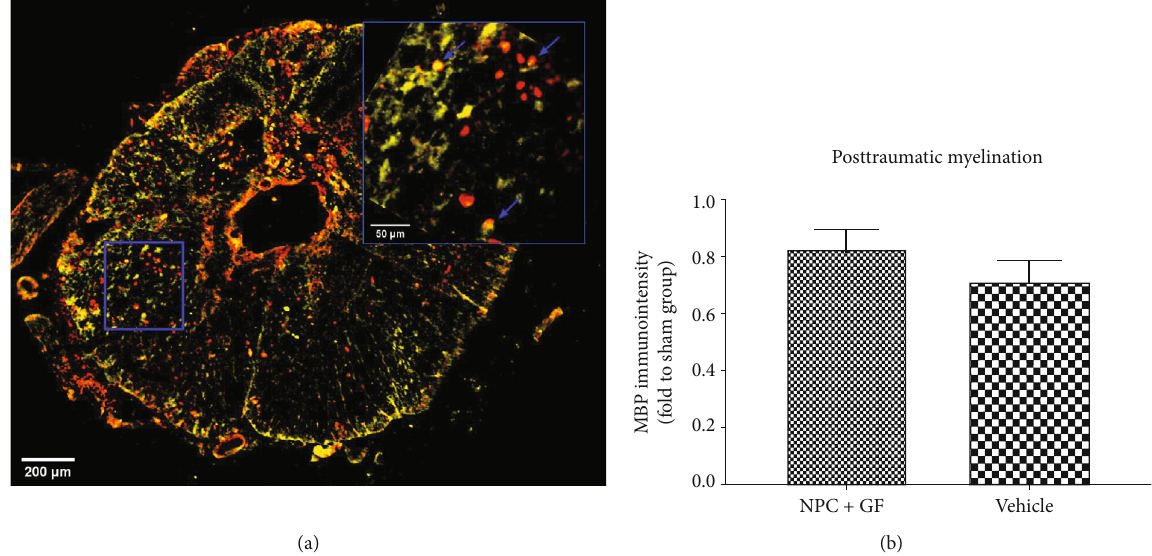
Figure 8: In vivo posttraumatic myelination 8 weeks after cervical SCI. (a) Spinal cord cross-section stained for APC (red), a marker for mature oligodendrocytes and MBP (yellow), depicting myelination (10x magni fi cation). Inlay (blue) with arrows (blue) showing the spatial relationship of MBP and APC in the injured spinal cord (40x magni fi cation). (b) Overall MBP-immunointensity as a surrogate marker for posttraumatic myelination expressed in proportion to (fold to) the sham group.